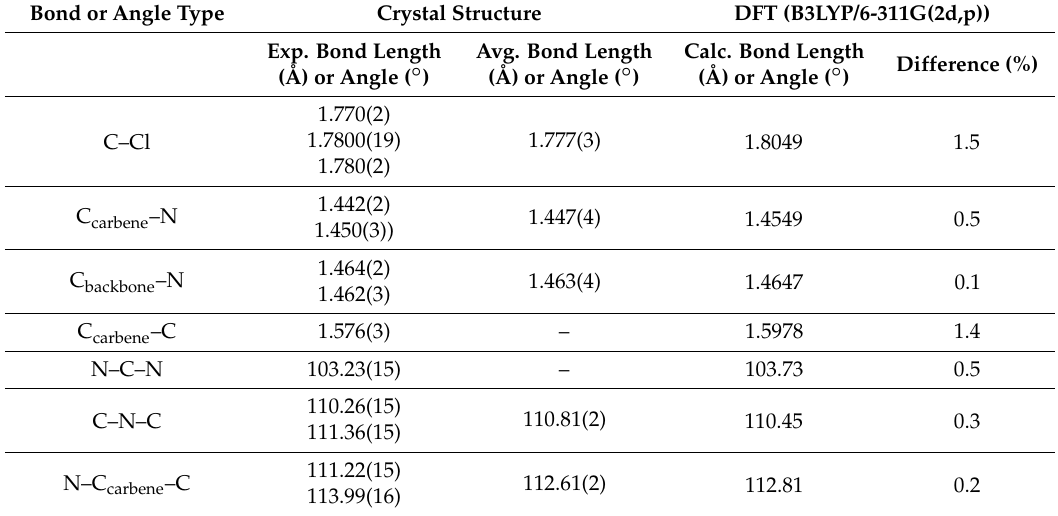
Table 1. Selected bond lengths (Å) and angles ( ◦ ) for the SIPr(H)CCl 3 adduct as obtained experimentally from the crystal structure, as well as the calculated values from a DFT